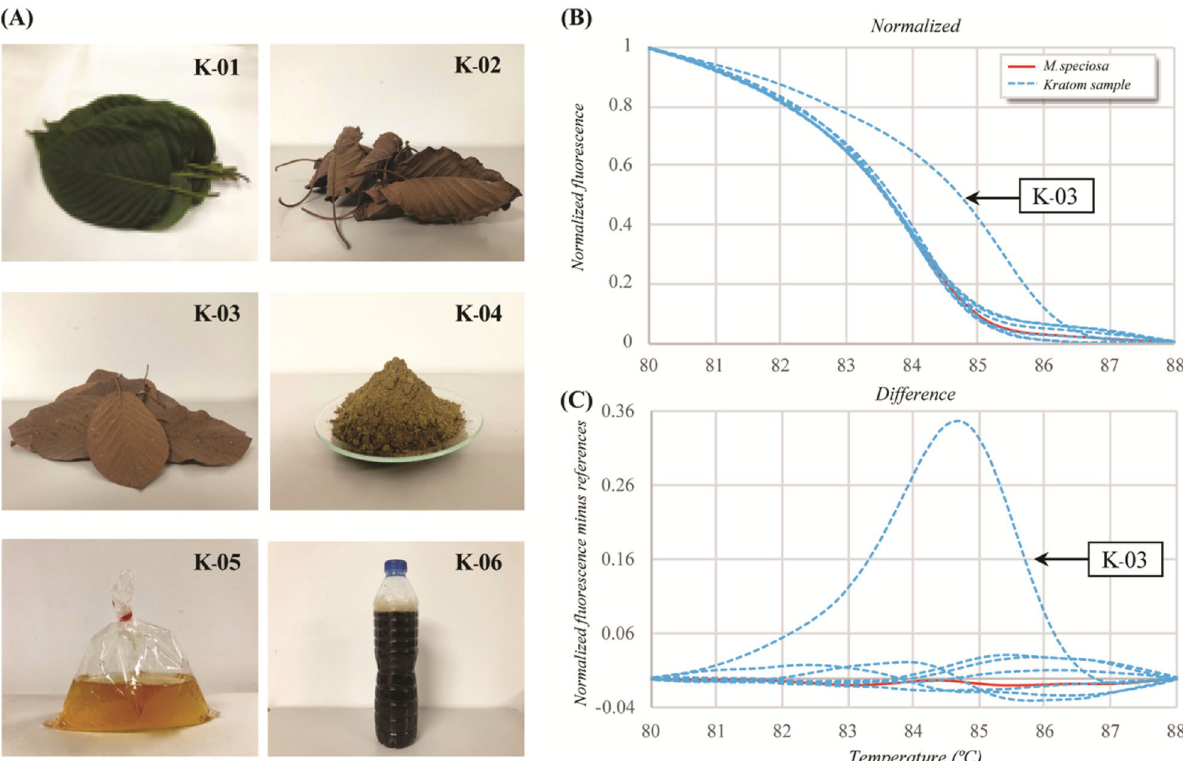
Figure 2. The investigation of suspected kratom samples via Bar-HRM analysis using the Mit_ITS2 primer pair. ( A ) Kratom samples in different forms. ( B ) and ( C ) Bar-HRM analysis of ITS2 regions of kratom samples, showing a normalized plot ( B ) and a difference plot ( C